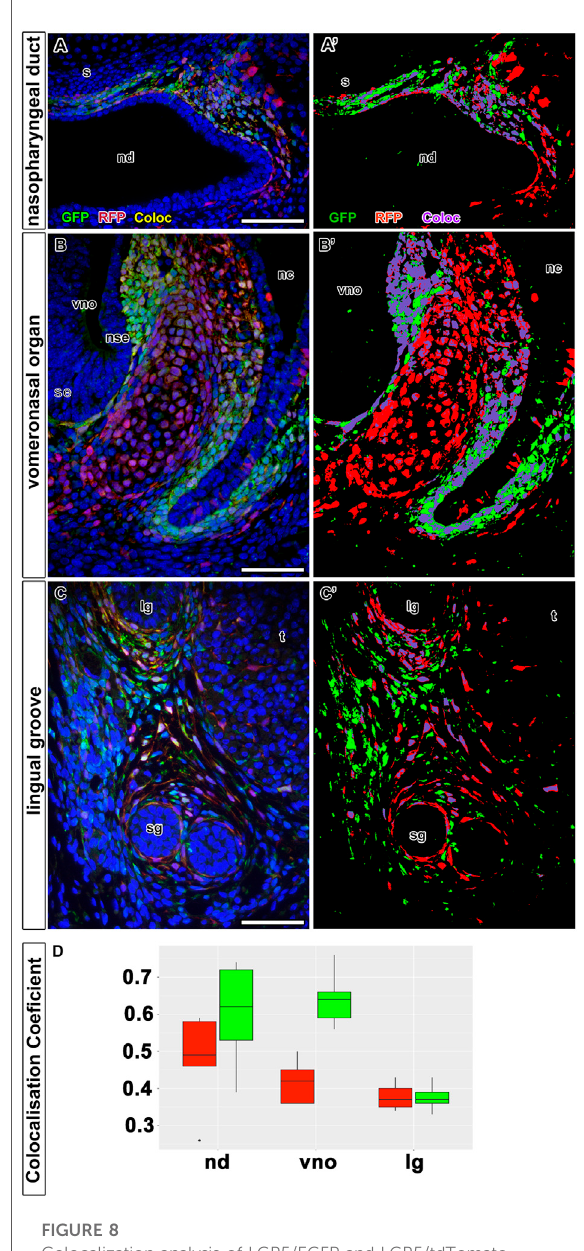
FIGURE 8 Colocalization analysis of LGR5/EGFP and LGR5/tdTomato positive cells on tissue sections. Quantitative analyses of colocalization between LGR5/EGFP positive cells (green color) and LGR5/tdTomato positive cells (red color) on immunoassayed tissue sections. Nuclei counterstained with DAPI are in blue. In left panel, there are representative images displaying overlayed channels red, green and blue (A,B,C) . Images in right panel (A´,B´,C´) are corresponding to binary masks images from the left panel demonstrating classi fi ed pixels above the threshold, which were used for colocalization coef fi cient calculation. Pixels for LGR5/EGFP channel are in green, LGR/tdTomato channel in red and co-localized pixels are labeled with turquoise color. (D) Boxplots summarizing colocalization analysis from all images of each group:nd, nasopharyngeal duct;vno, vomeronasal organ; lg, lingual groove. Boxplots fi lled with red color representing colocalization coef fi cient for red channel, and boxplots fi lled with ( Continued